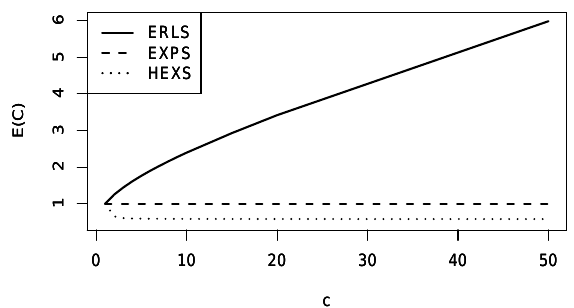
Figure 5: Plot of E ( C ) under various